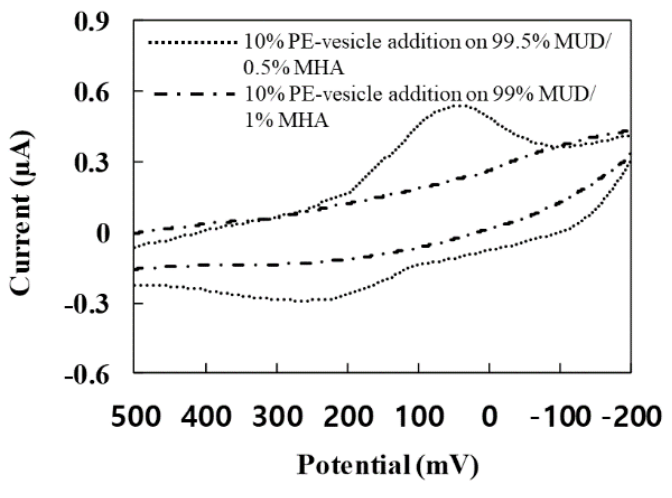
Figure 4. CV responses after the 10% PE-vesicle addition on the monolayer prepared respectively with 99.5% MUD/0.5% MHA and 99% MUD/1% MHA.